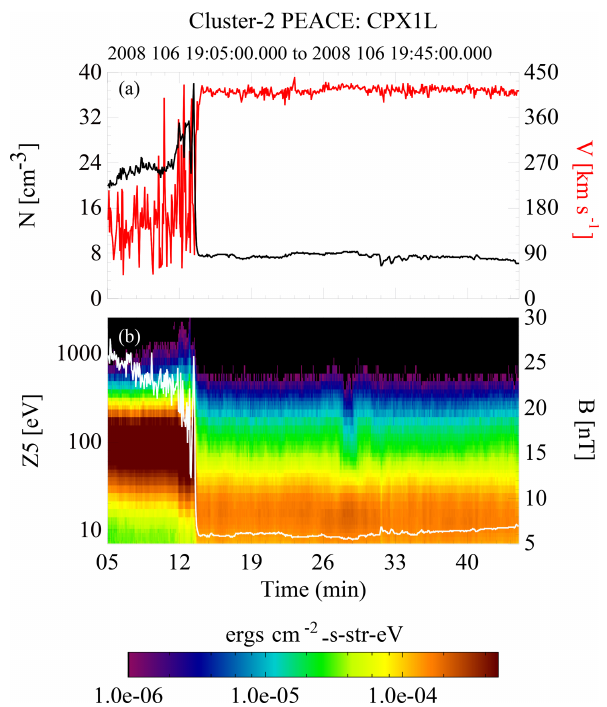
Figure 11. An overview of the 15 April 2008 event. Panel (b) shows an energy spectrogram of electron data from one of the near-ecliptic sensors of PEACE overlaid on a trace of the magnetic field (white). Panel (a) contains the full electron density (black) and the bulk fluid velocity (red). All data were acquired from C2. At about 09:15UT the spacecraft exits the magnetosheath, passes through the bow shock, and enters the upstream region and is in the foreshock for the remaining time period, with the exception of a brief excursion into the solar wind at about